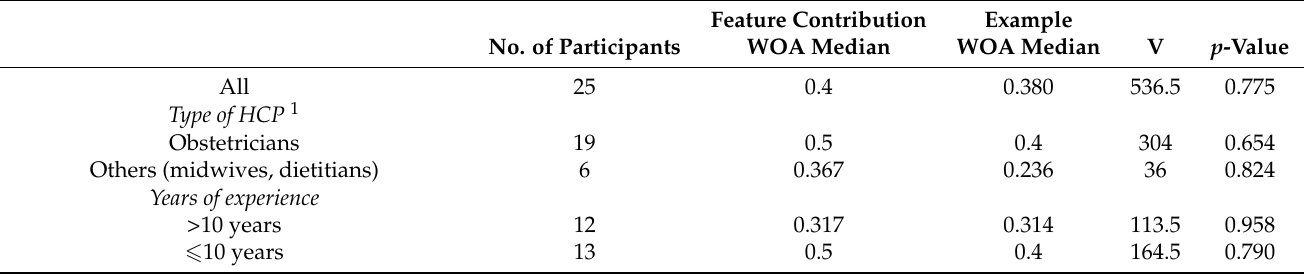
Table 1. Comparison of WOA between two XAI methods in all and subgroups of participants. Median is used as cutoff for continuous features (years of